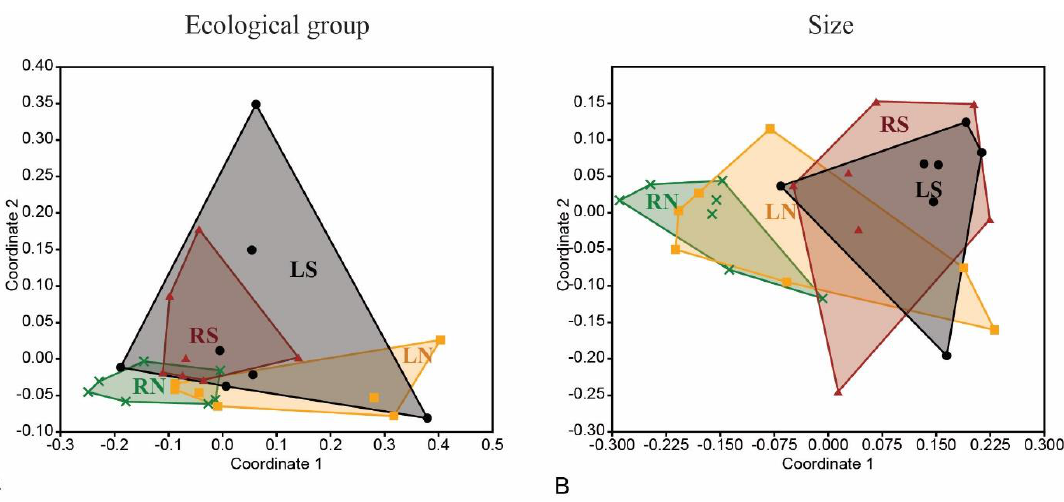
Figure 5. Non-metric multidimensional scaling (NMDS) with Bray-Curtis dissimilarity index illustrating the separation of samples based on the relative abundances of ecological groups ( A ) and size classes ( B ). Markings: green cross—samples from upstream, right bank (RN), orange filled square—samples from upstream, left bank (LN), brown filled triangle—samples from downstream, right bank (RS), black dot—samples from downstream, left bank (LS).